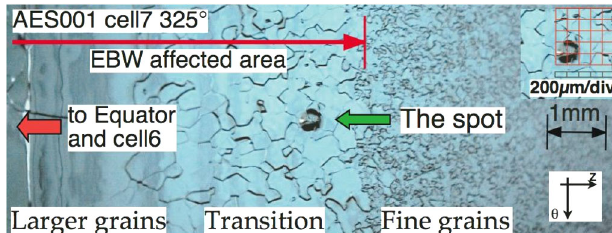
FIG. 9. (Color) Cat’s-eye spot found at the equator region of cell 7, 325 (cid:3) . The diameter is about 400 (cid:1) m